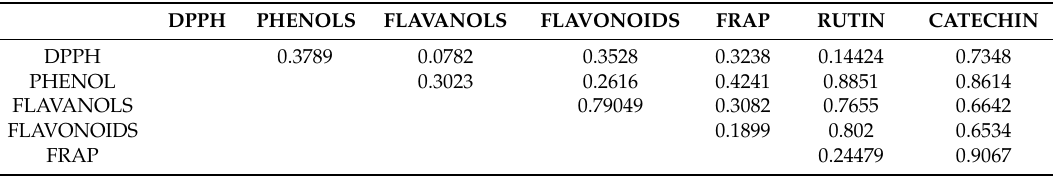
Table 3. Correlation matrix between total phenolics, diphenyl-2-picrylhydrazyl (DPPH), and the ferric reducing antioxidant power (FRAP) with catechin and rutin in diverse apple